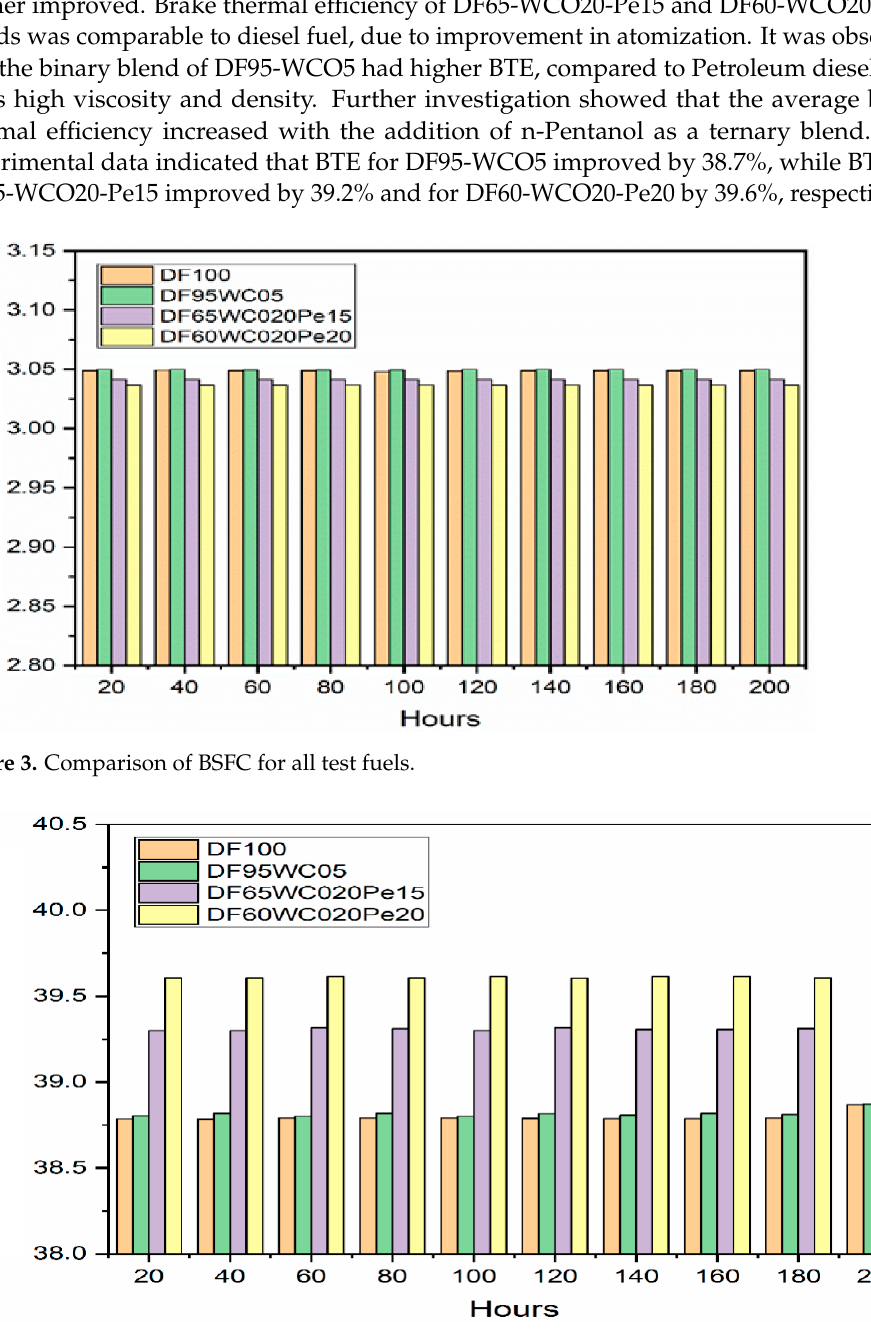
Figure 4. Comparison of BTE for all test fuels.